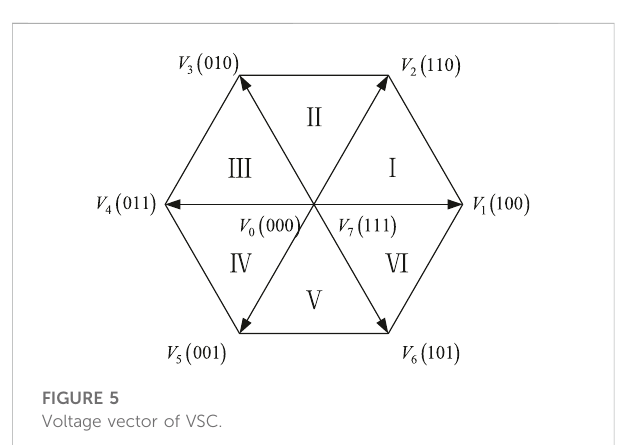
Voltage vector of VSC.